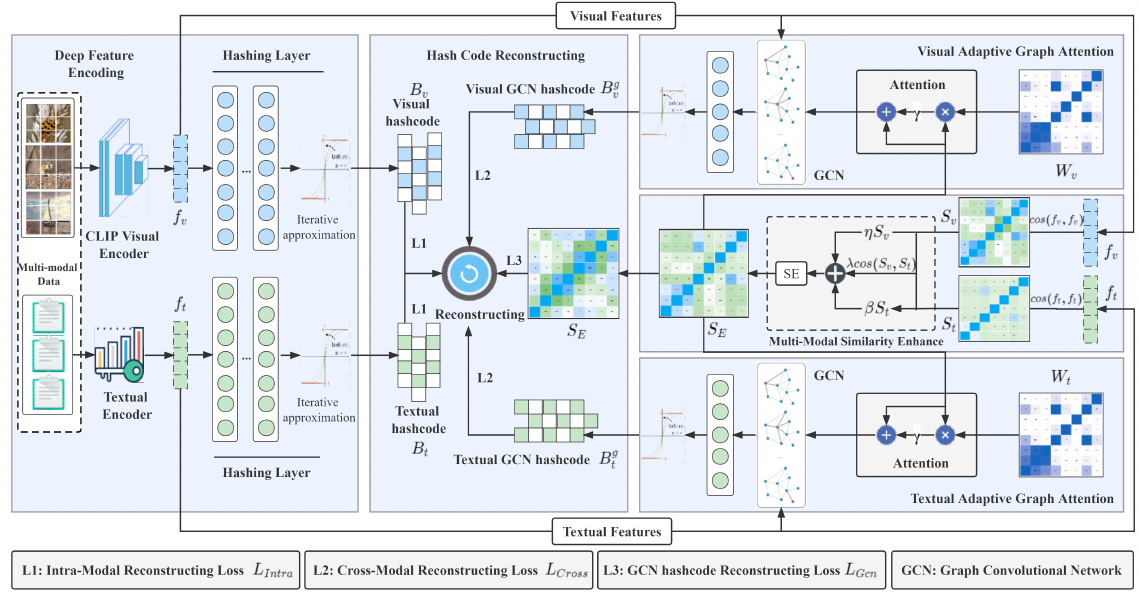
Figure 2. Illustration of our proposed CLIP-based Adaptive Graph Attention Network (CAGAN), which consist of four modules: the deep feature encoding, multi-modal similarity enhancing, adaptive graph attention, and hash codes reconstructing